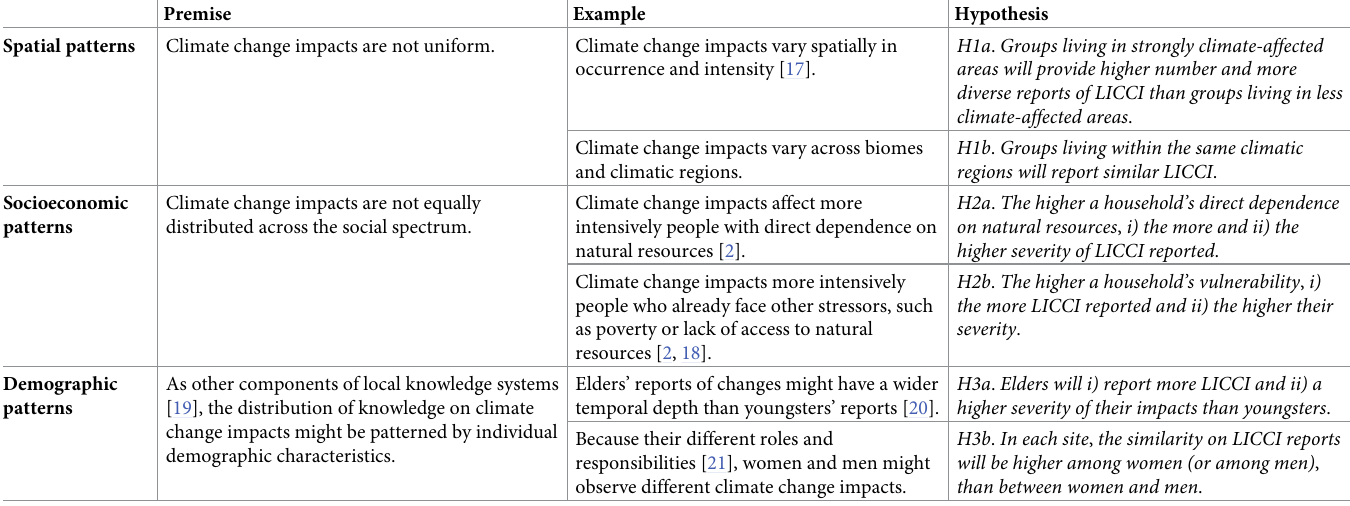
Table 1. Hypotheses that guide the